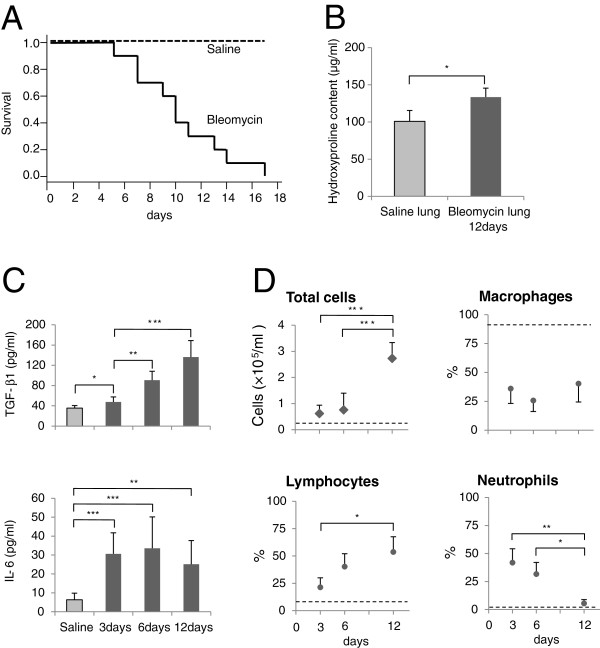
Characterization of the bleomycin-injured lung model. (A) Mice (solid line, N = 10) were intratracheally administered bleomycin. In mice treated with bleomycin, mortality was as high as 70% by day 12. (B) Saline-treated lungs at day 12 (N = 3) and bleomycin-injured lungs at day 12 (N = 3) were homogenized at the same time. Hydroxyproline content was higher in bleomycin-injured lungs at day 12 than in saline-treated lungs. Results represent the mean (± s.d.) of three experiments. (C) BAL fluid of saline-treated lungs (N = 3) was collected at day 12. BAL fluid of bleomycin-treated lungs was collected at days 3 (N = 3), 6 (N = 3), and 12 (N = 5). IL-6 and TGF-β1 concentration in BAL fluid at days 3, 6, and 12 was significantly higher than that of saline-treated lungs. Results represent the mean (± s.d.) of three or five experiments. (D) Total and differential cell count in BAL fluid of mice treated by bleomycin or saline (dashed line). BAL fluid of saline-treated lungs was collected at days 12 (N = 3). BAL fluid of bleomycin-treated lungs was collected at days 3 (N = 3), 6 (N = 3), and 12 (N = 5). Dashed line indicates the average of BAL fluid of saline-treated lungs. Results represent the mean (± s.d.) of three or five experiments. *, P < 0.05; **, P < 0.001; ***, P < 0.0001. BAL, bronchoalveolar lavage; s.d., standard deviation.